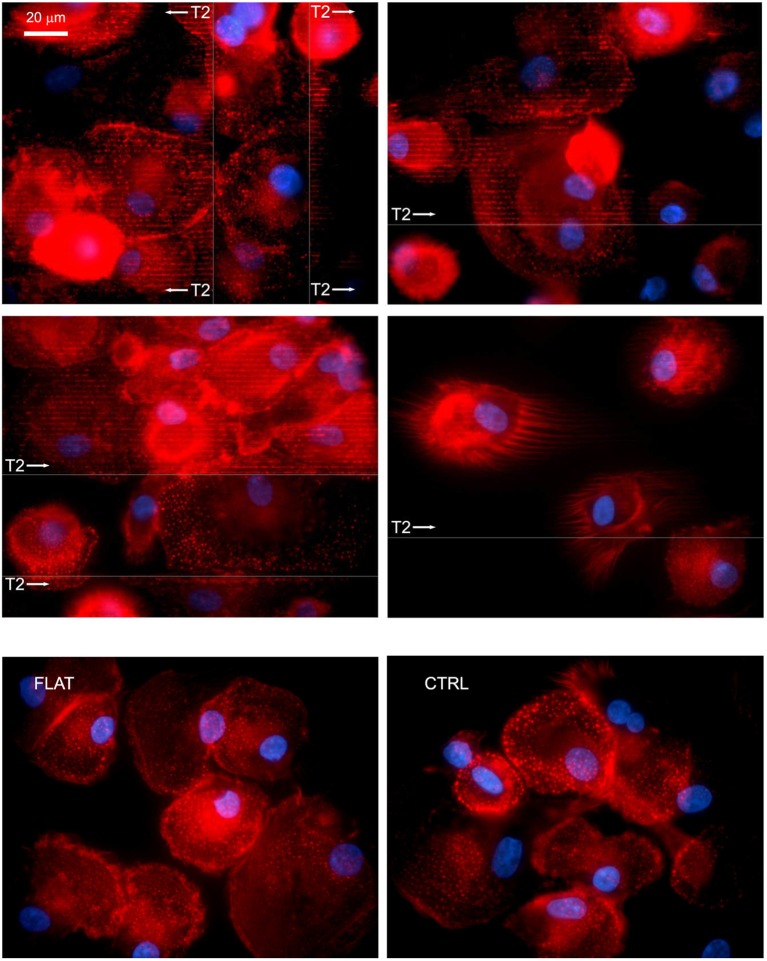
MPCs interact with NGs at the adhesion level. After overnight incubation on nano-structured T2 gratings, most of the seeded MPCs resulted firmly attached and showed the numerous podosomes aligned to the grating direction (white arrows) and in correspondence to the crests. Similarly, filopodia showed an alignment to the grating direction. Fluorescence images were acquired by confocal microscopy and immunostaining of F-Actin; arrows show grating direction, and area. The bottom row shows cells on FLAT (left) and CTRL (right).